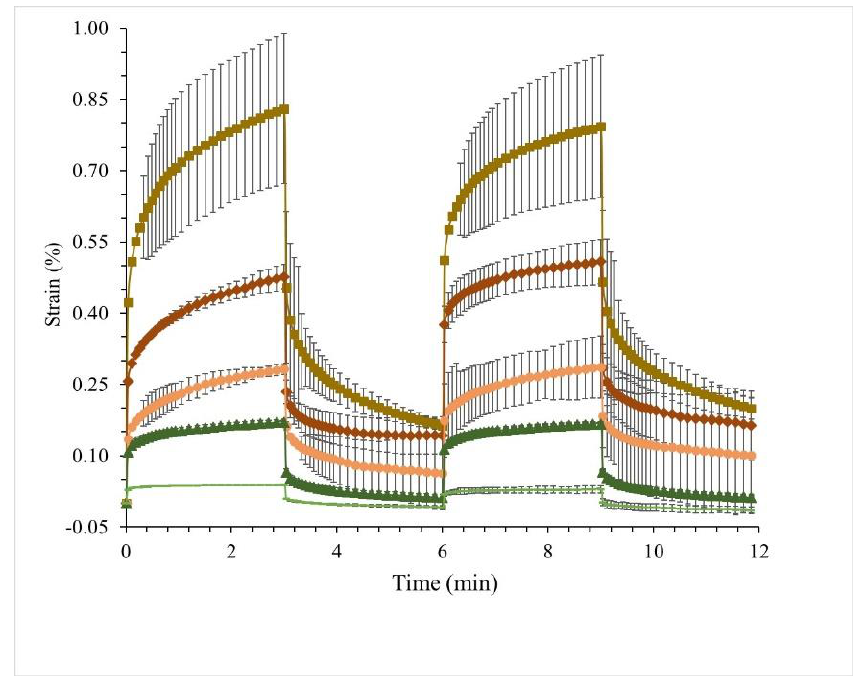
Figure 5. Creep–recovery cycles in two runs of WPI emulsion gels; ( ■ ) MWP(3.5), ( ♦ ) MWP(2), (●) MCI(3.5), ( ▲ ) MCI(2), ( ▬ ) WPI(10). Given are means of two repetitions ± std. deviations.